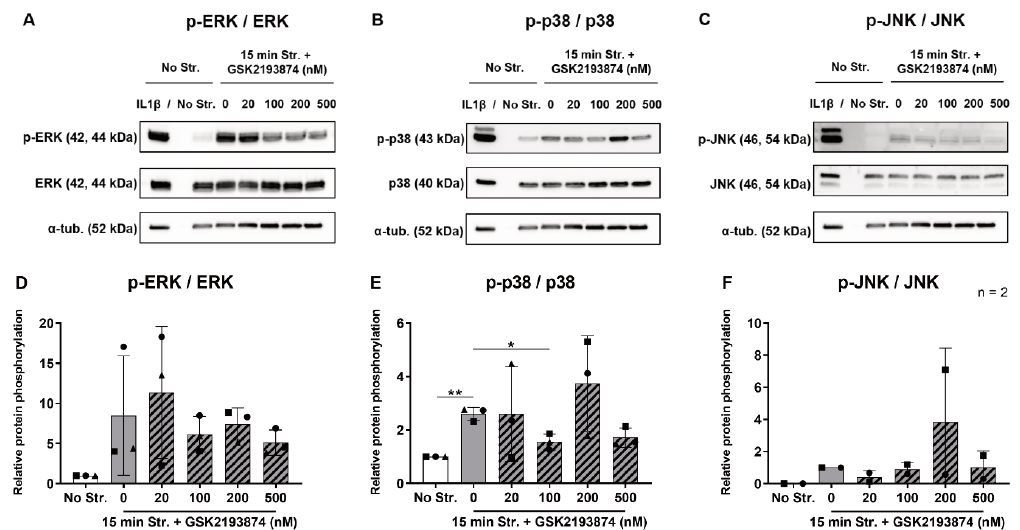
Figure 4. Representative Western blots from one donor ( A – C ) and densitometry analysis ( D – F ) of the phosphorylated and total ( A , D ) ERK 1 / 2; ( B , E ) p38; and ( C , F ) JNK immediately after no (white bar) or 15 min (grey bars) of cyclic stretching at 20% strain and 1 Hz in the absence or presence (hatched bars) of 20–500 nM of the TRPV4 antagonist GSK2193874. Non-stretched cells treated with IL1 β were used as a positive control for the blots. One same blot of α -tubulin is shown three times as a loading control. n = 3 donors ( n = 2 for p-JNK); mean ± SD; * p < 0.05, ** p < 0.01.